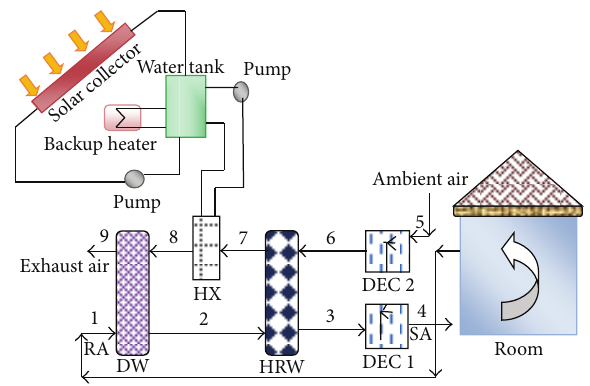
Figure 2: Solar desiccant cooling in recirculation mode